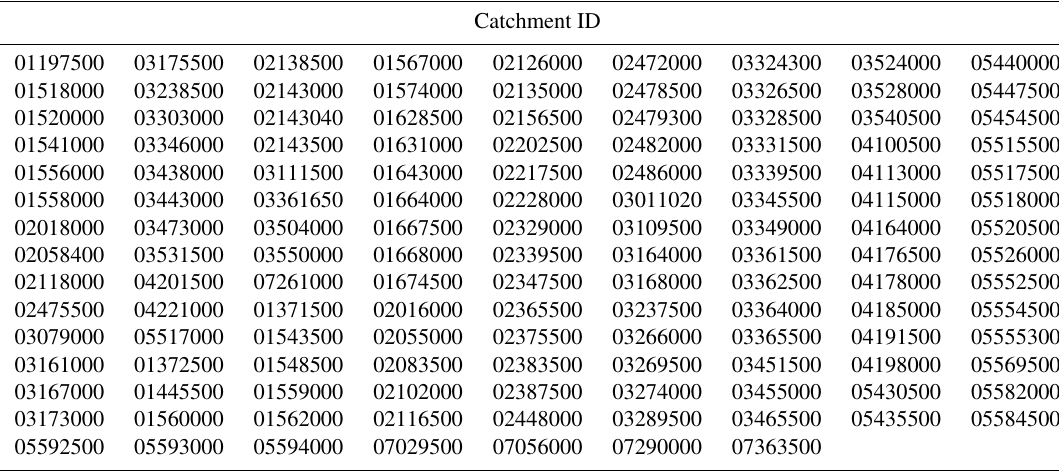
Table A1. USGS ID of the selected MOPEX